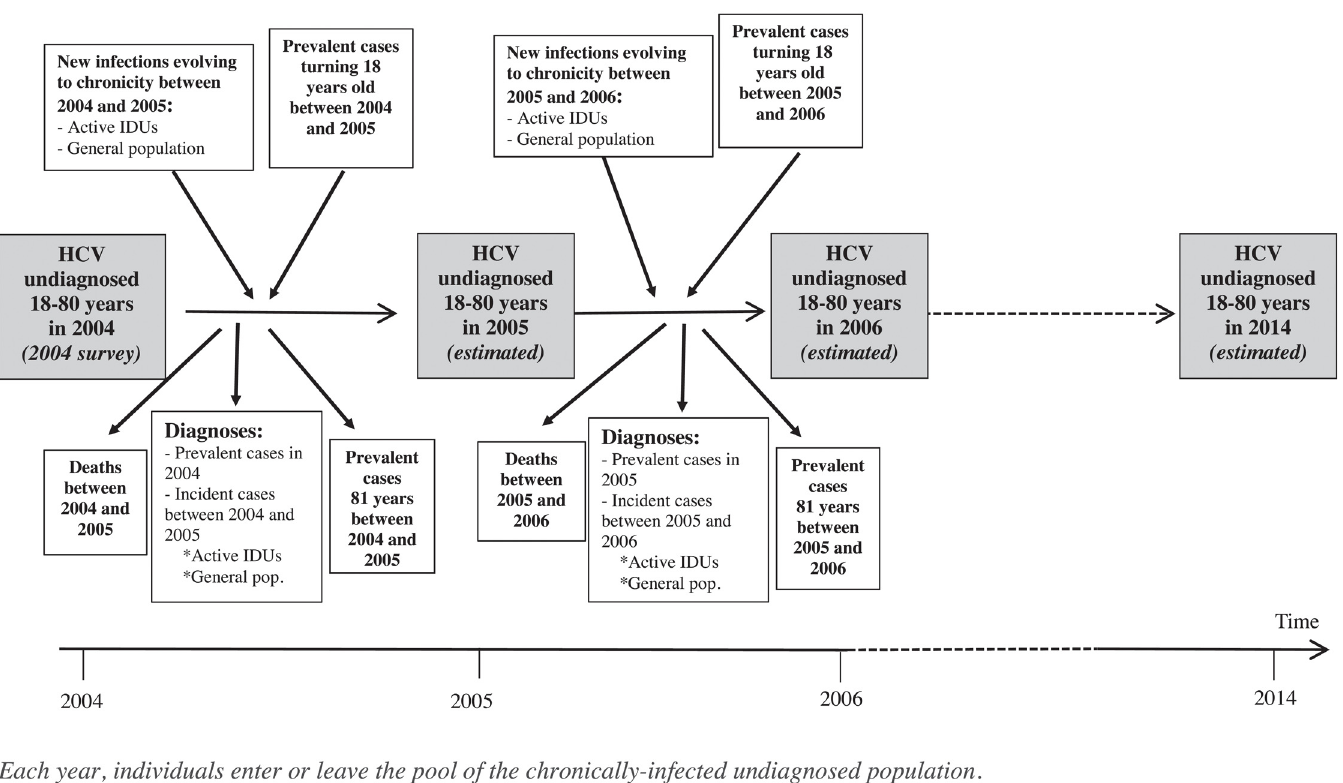
Fig 1. Chart flow of the